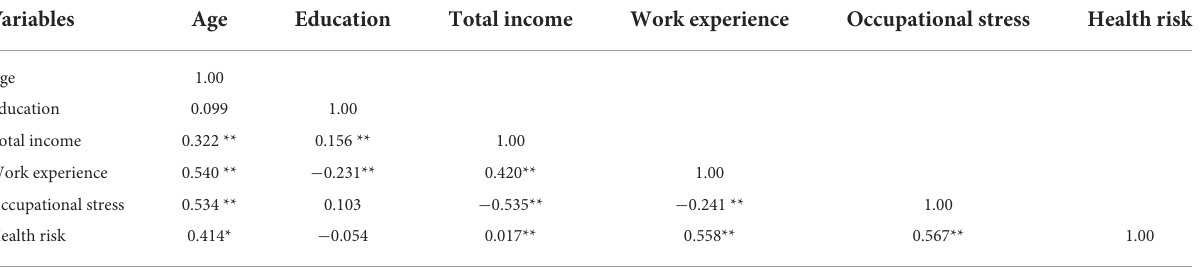
TABLE 14 Correlation matrix showing inter-correlations among some selected major variables (age, education, total income, work experience, nature of occupational stress, and health risk) of all the category of respondents taken together ( N = 350).